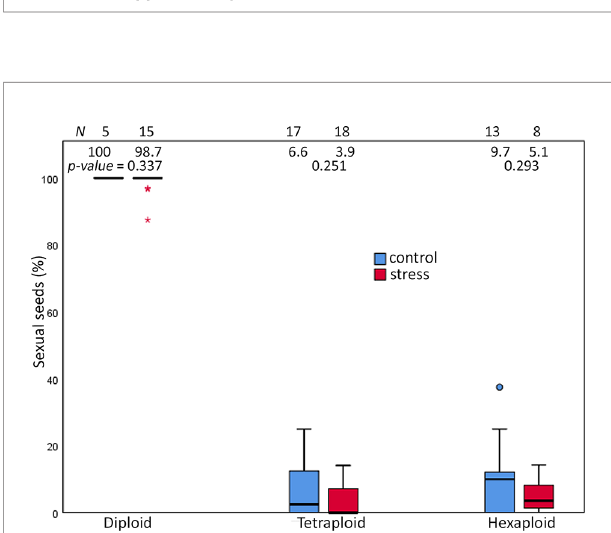
FIGURE 3 | Proportions of well-developed seeds in the R. auricomus complex plants grown in climatic chambers under prolonged photoperiod (stress) and shortened photoperiod (control). Mean values and statistical signi fi cance are given in fi gure. N = number of individuals. For the test statistic, see Supplementary Table 2